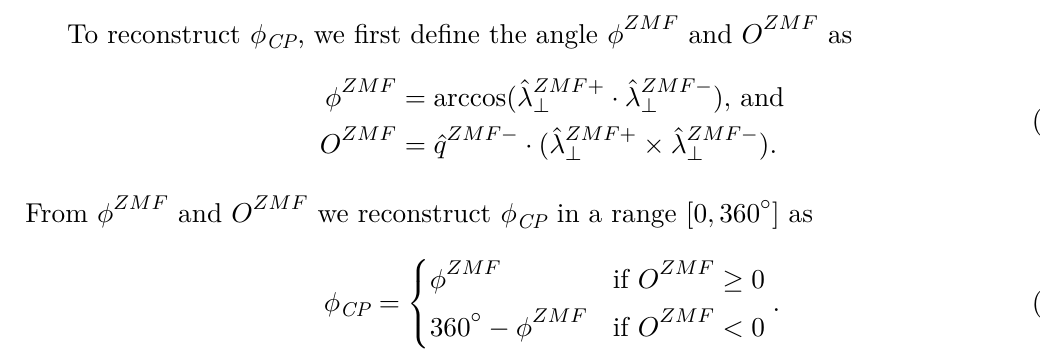
for various decay configu- Figure 3 . Illustration of the t lepton decay planes and the angle φ CP rations. The decay planes are illustrated with the shaded regions, and either the vector ˆ λ or the momentum vector of the neutral pion is in the decay plane. The illustrations are in the frame in which the sum of the momenta of the charged particles is zero. Left: the decay plane for the decays t − → p − + n and t + → p + + n . Middle: the decay plane as reconstructed from the neutral and charged pion momenta. Right: φ for the mixed scenario, in which one t lepton decays to a pion CP while the other decays via an intermediate r